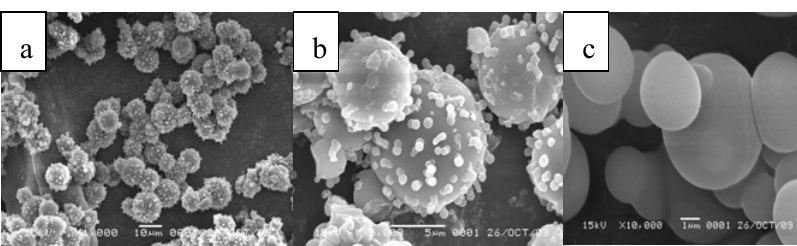
Figure 2. The SEM images of the carbon based acid with the reaction time of 4 h.